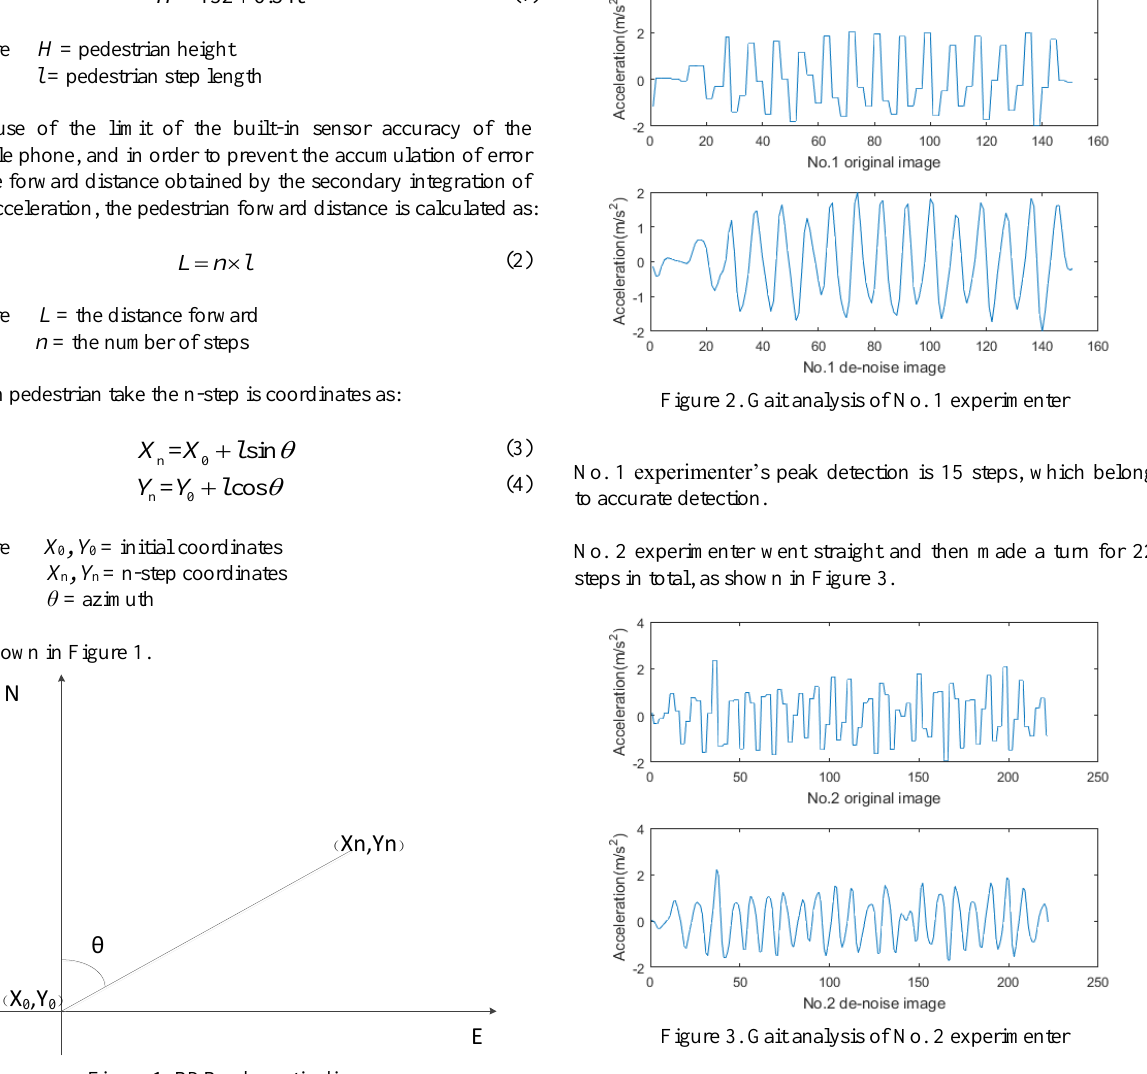
Figure 1. PDR schematic diagram